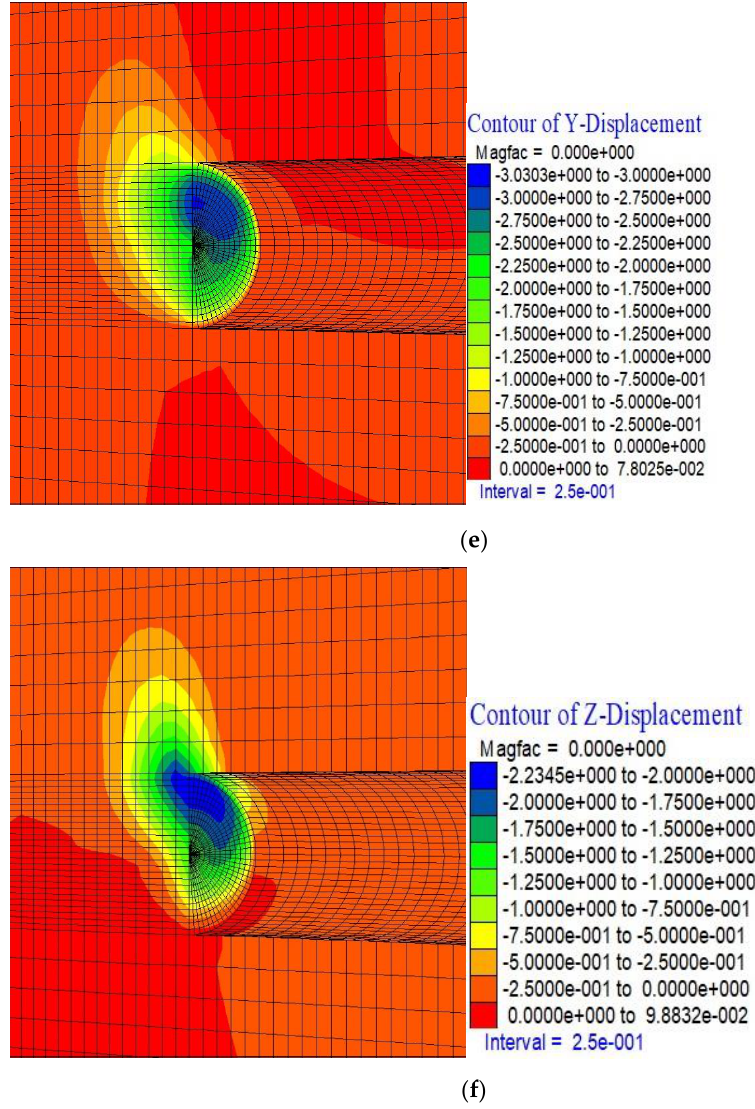
Figure 10. Displacements in Y-direction for the Analysis-1 ( a ); displacements in Z-direction for the Analysis-1 ( b ); displacements in Y-direction for the Analysis-2 ( c ); displacements in Z-direction for the Analysis-2 ( d ); displacements in Y-direction for the Analysis-3 ( e ); displacements in Z-direction for the Analysis-3 ( f ) (units in m). Table 4. Parameters used for segment lining.